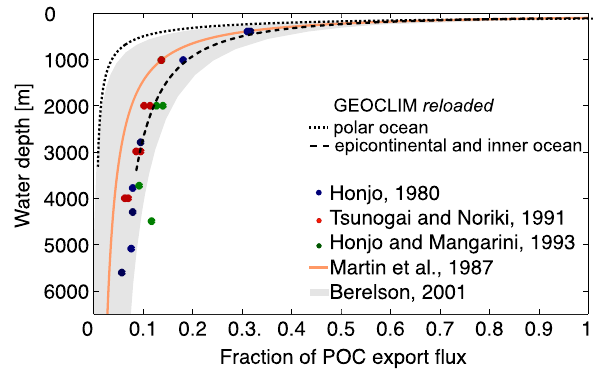
Figure 3: Observed and parameterized depth profiles of POC fluxes used in GEOCLIM reloaded in the global ocean. The depth-profiles of POC fluxes are normalized to the POC export flux.